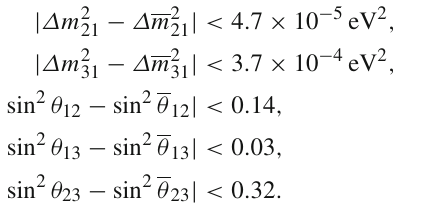
Fig. 9 One-dimensional DUNE constraints compared with current constraints calculated in Ref. [55]. The left half of the figure shows constraints on the standard oscillation parameters, written in the bot-